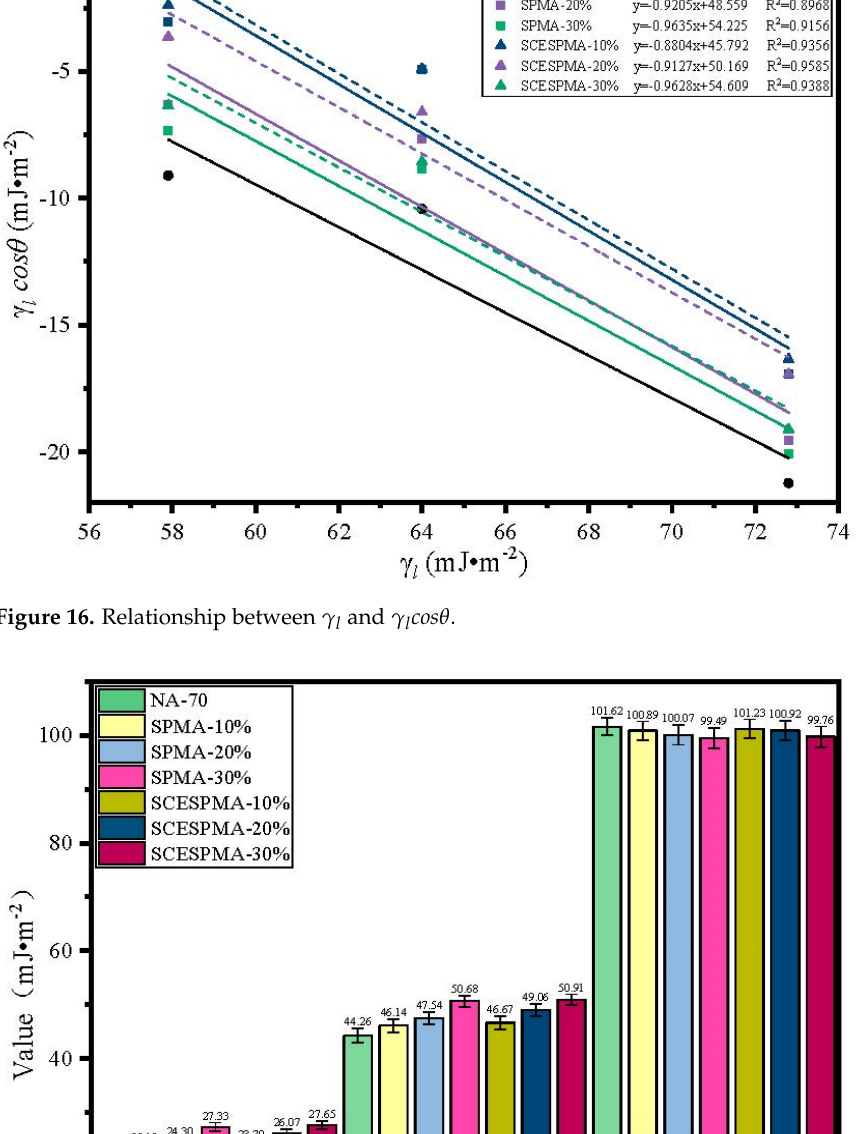
Figure 17. Adhesion properties of SPMA and SCESPMA.